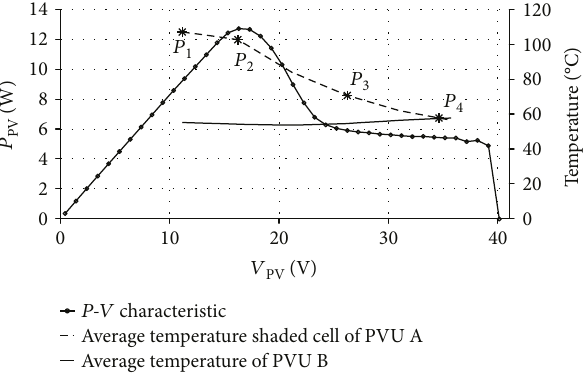
Figure 8: P - V characteristic of the two series-connected PVUs: average temperature of the shaded cell of the PVU A and average temperature of the PVU B as a function of the operating voltage. 26 September 2017, Aversa (CE), Italy. S 1 = 616 W/m 2 characterizes the unshaded cells, and S 2 = 145W/m 2 characterizes the shaded cell; T amb = 25 ° C